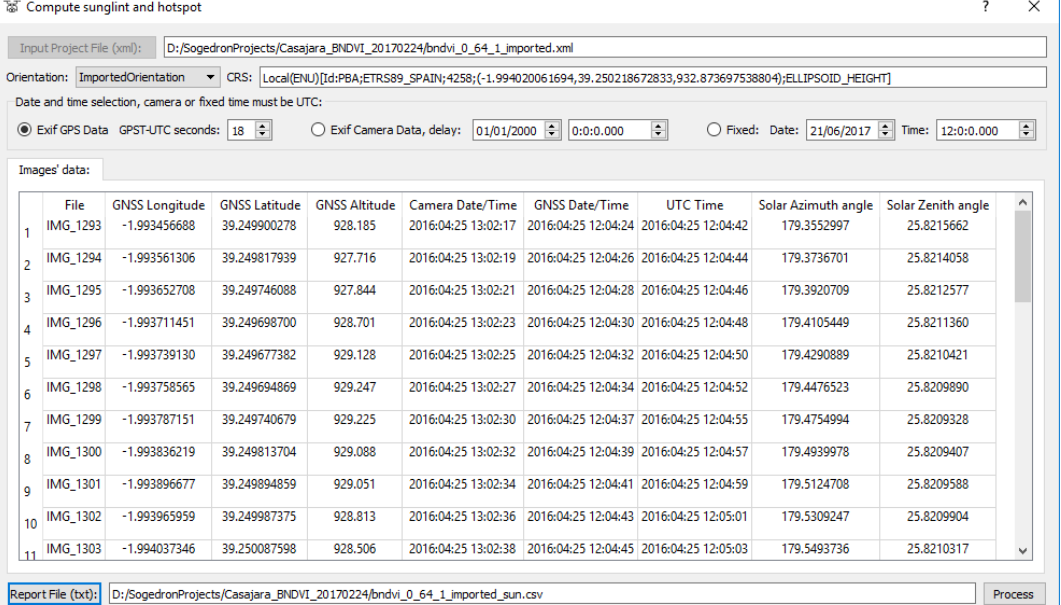
Table 3. Example of hotspot and sun glint detection in image coordinates.